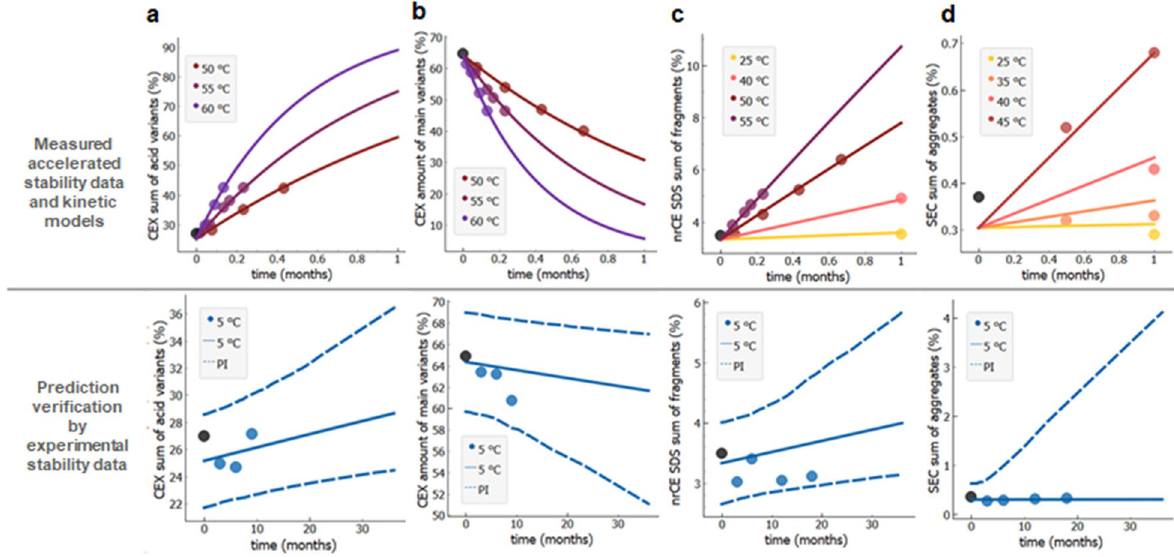
Figure 7. Rapid stability prediction for mAb1 molecule from stability data at temperatures 25 to 60 °C. (a) Two weeks data for acidic variants, (b) three weeks for main variants, both measured by CEX, (c) four weeks for fragmentation measured by nrCE-SDS and (d) four weeks for sum of aggregates by SEC. Highly accelerated experimental stability data (data points) and model fits (full lines) are shown in the upper panels, to generate prediction curves (full line) and prediction intervals (dashed lines) with measured data (solid circles) in the bottom panels. Note that different temperature intervals had to be used for different stability quality attributes, depending on the nature of degradation process kinetics. Measured value at t = 0 is designated by a black solid